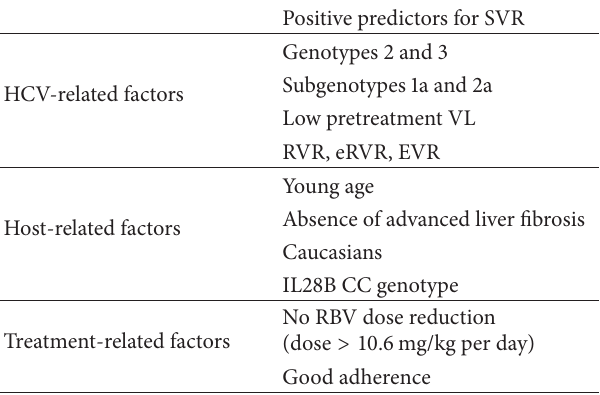
Table 1: Some classical of predictors of sustained viral response